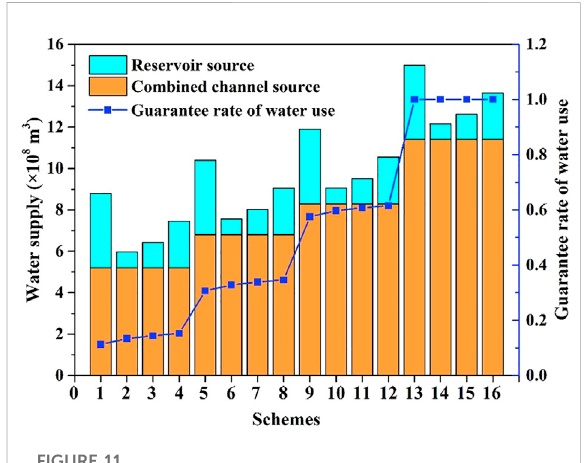
FIGURE 11 Sixteen schemes when both the combined channel source and reservoir source were